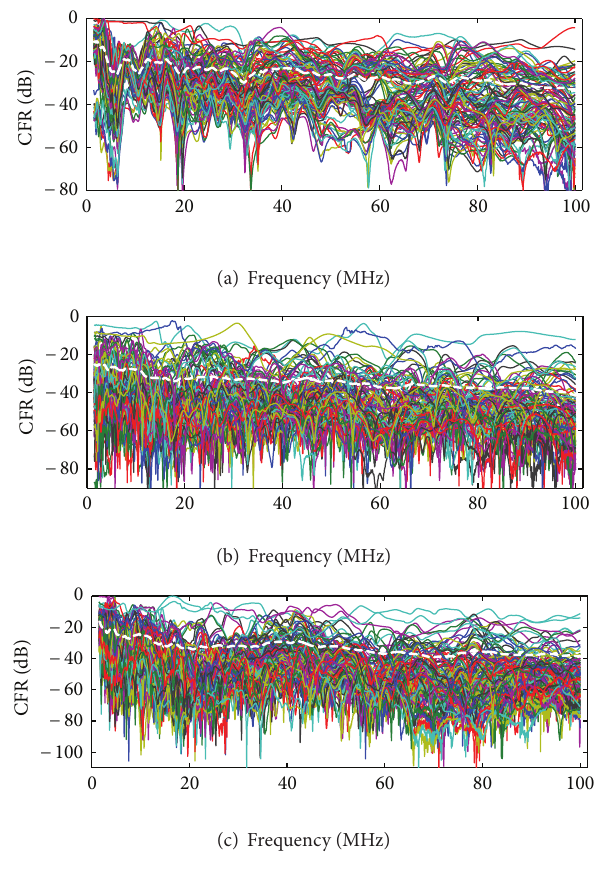
Figure 4: Measured channel frequency responses. From top to bottom, sites 1, 2, and 3. In all cases, the mean profile is also shown (dashed